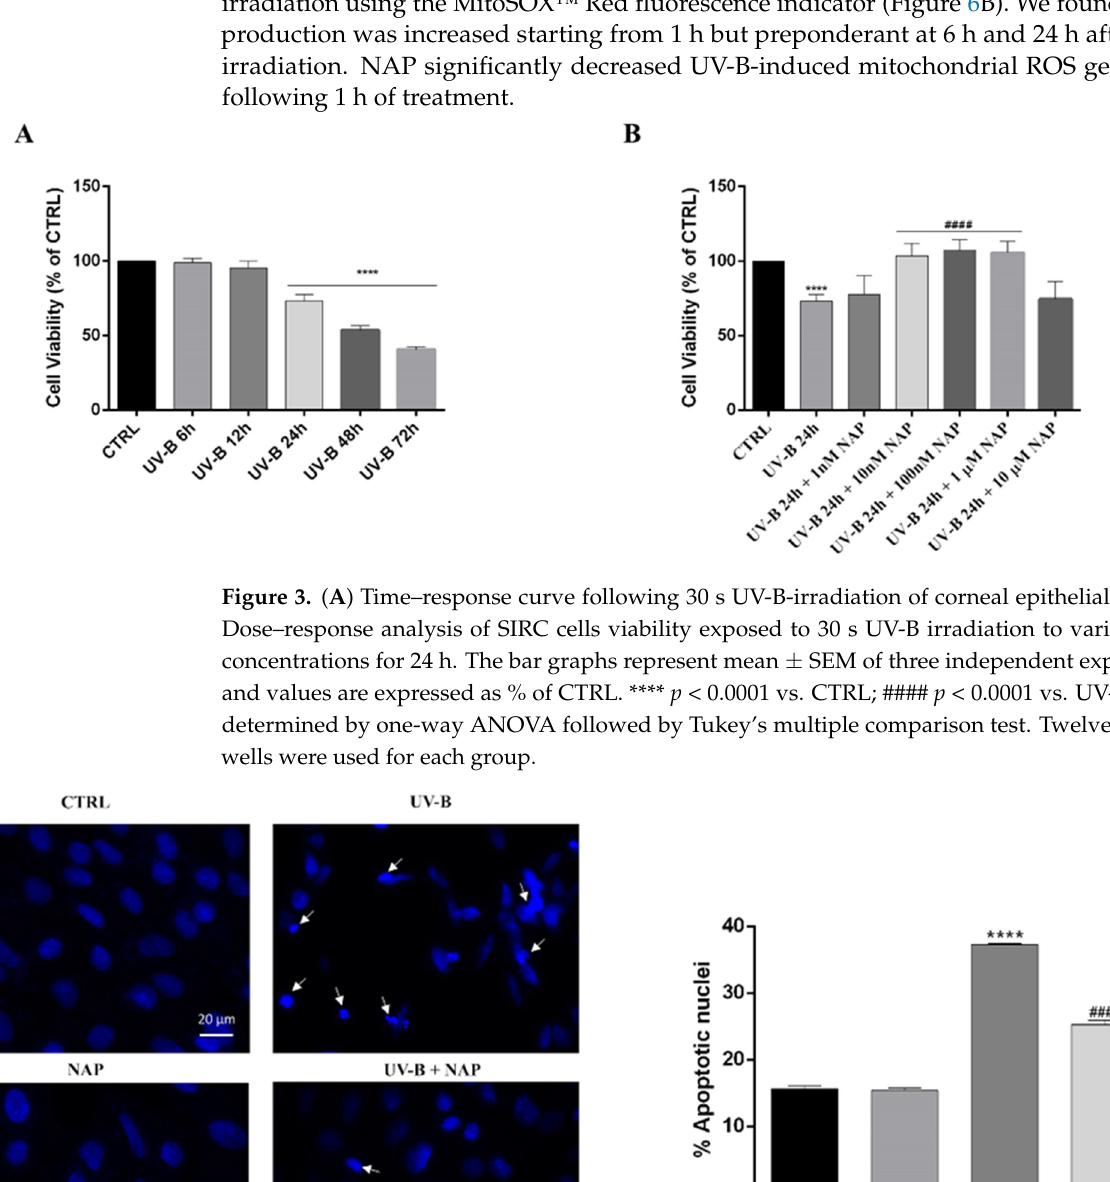
Figure 4. NAP decreased apoptotic cell death induced by UVB-irradiation. SIRC cells were stained with the fluorescent nuclear dye Hoechst 33342 and viewed at ×100 magnification. Nuclei showing the typical features of apoptotic degeneration including chromatin condensation and fragmentation (indicated by white arrows) have been detected by intense blue fluorescence. The bar graph represents mean ± SEM of apoptotic cells percentages calculated counting cells from seven fields per dish, in a fixed pattern. **** p < 0.0001 vs. CTRL; #### p < 0.0001 vs. UV-B as determined by one-way ANOVA followed by Tukey’s multiple comparison test. Digital micrographs are obtained with an Axiovert 40 fluorescence microscope (Carl